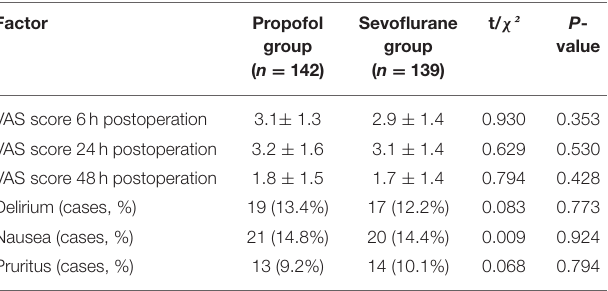
TABLE 2 | Adverse characteristics in the two groups.